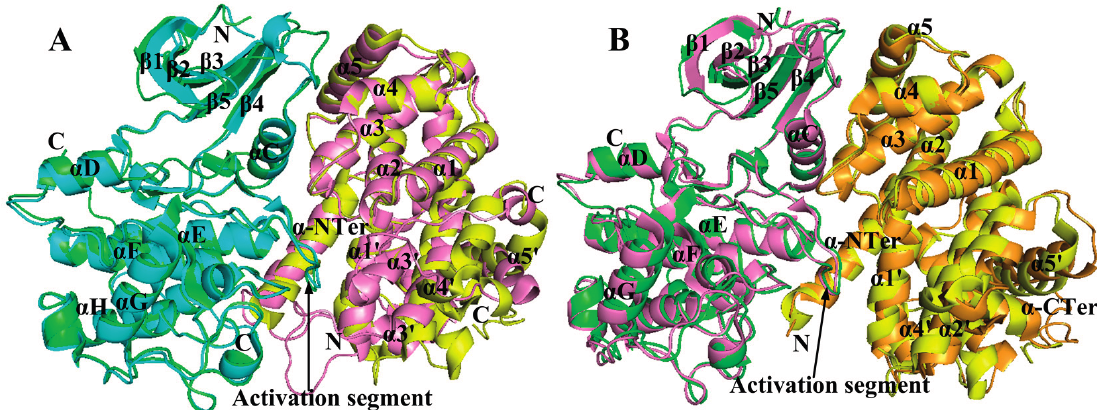
Figure 10. The structure of pCDK2/cyclin A superimposed on pCDK2/cyclin E1 and pCDK2/cyclin B, respectively. ( A ) Structural superposition of pCDK2/cyclin A (CDK2 in green and cyclin A in yellow, respectively) and pCDK2/cyclin E1 (CDK2 in cyan and cyclin E1 in pink, respectively); ( B ) The alignment of pCDK2/cyclin A and pCDK2/cyclin B (CDK2 in pink and cyclin B in orange, respectively). Coordinates used for CDK2/cyclin A, CDK2/cyclin B and CDK2/cyclin E1 are 1QMZ, 2JGZ and 1W98,